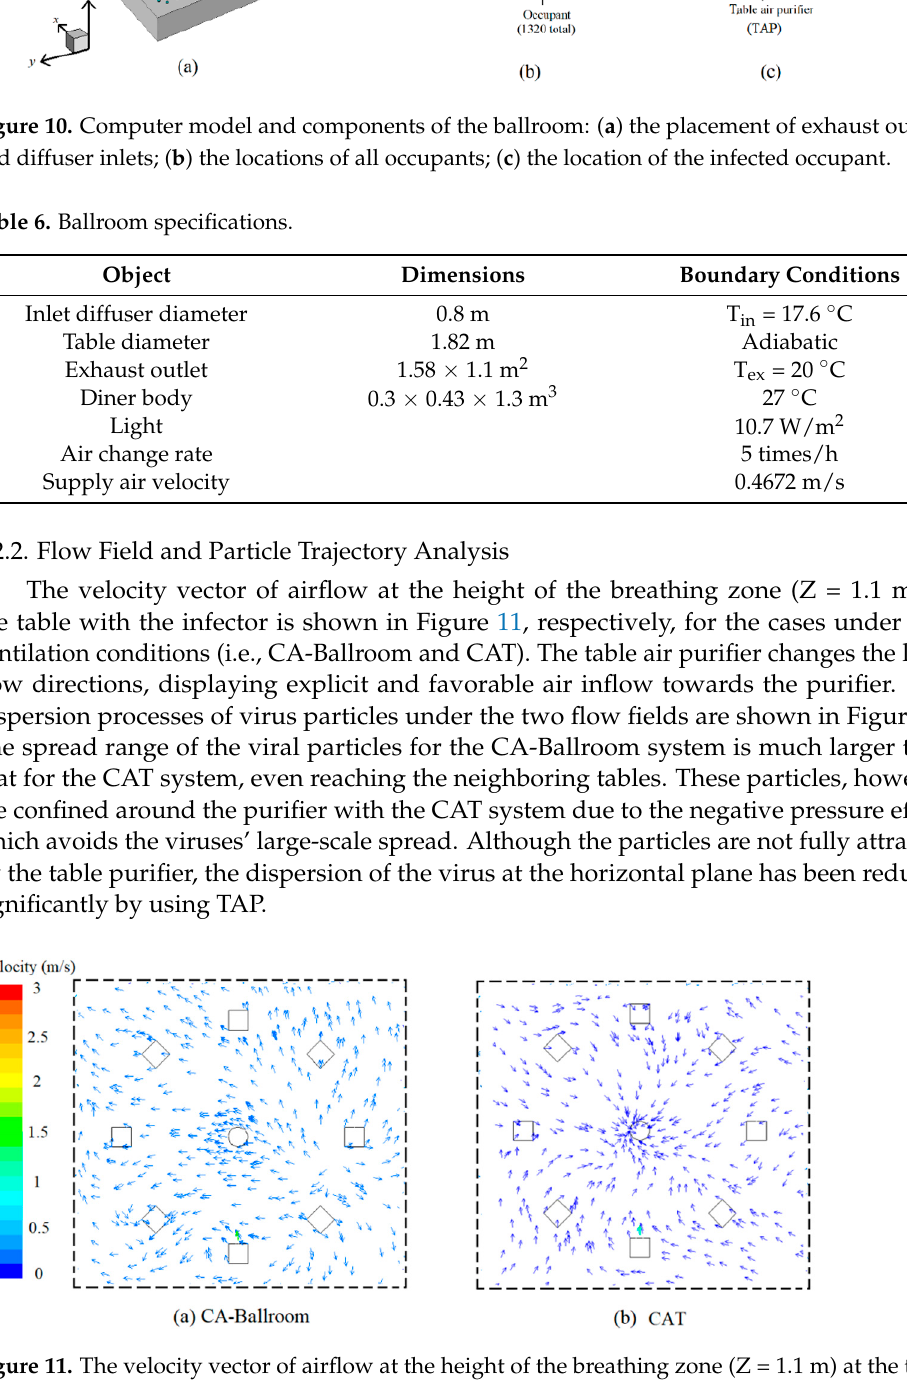
Figure 12. The dispersion processes of viral particles under two ventilation conditions: ( a ) CA-Ball- room; ( b ) CAT. 4.2.3. Fate Analysis of the Virus-Carrying Exhaled from the Infected Occupant Figure 13 compares the percentage of the particles that are, respectively, exhausted from the central air outlets, purified by the purifier, and deposited on different surfaces under the two ventilation conditions. Although only 12% of particles were purified by the TAP, which is attributed to the longer distance between the unit and the infector (the larger diameter of the dining table) compared to the restaurant case, the TAP helps reduce the deposition of particles on the occupants (potential cross-infection risk) from 29% to 11%. More particles were pushed up towards the ceiling (49%) due to the upward exit flow of the TAP, rather than distributing horizontally, which is a potential cause of cross- infection. We obtained 60.3% of N reduction for the CAT compared to CA-Ballroom using Equation (8) and the data in Figure 13. While this number is lower than that in the restaurant, it is still promising, especially considering the small size and capacity of the purifier. The ar- rangement of a table air purifier can be as effective as more elaborate solutions installed in the HVAC system at a lower cost. Flexible solutions, such as portable air purifiers, can be redeployed throughout the property as needed.